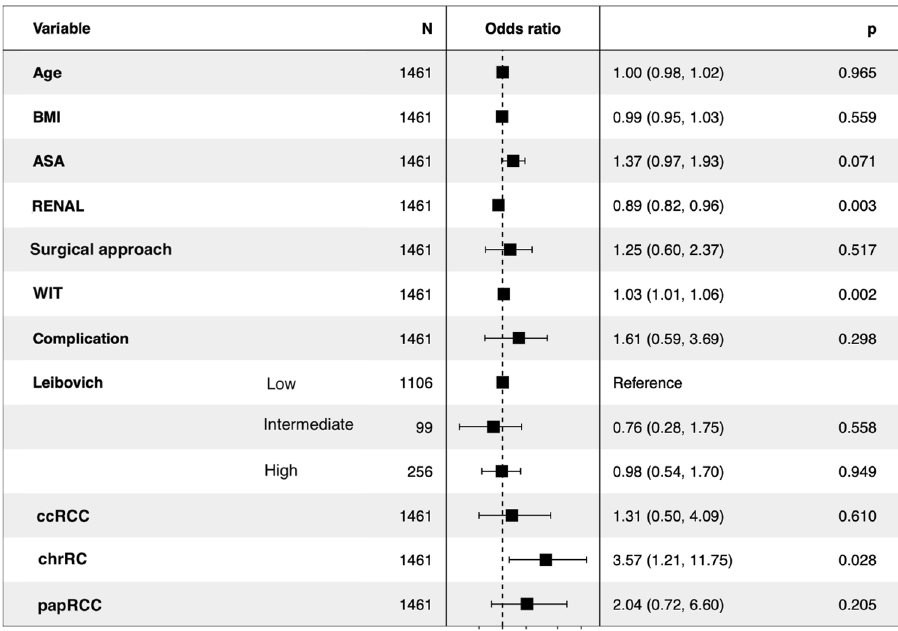
Figure 3. Multivariable analysis of risk factors for positive margin. Lower RENAL Score, Longer WIT and chrRCC are prognostic factors of